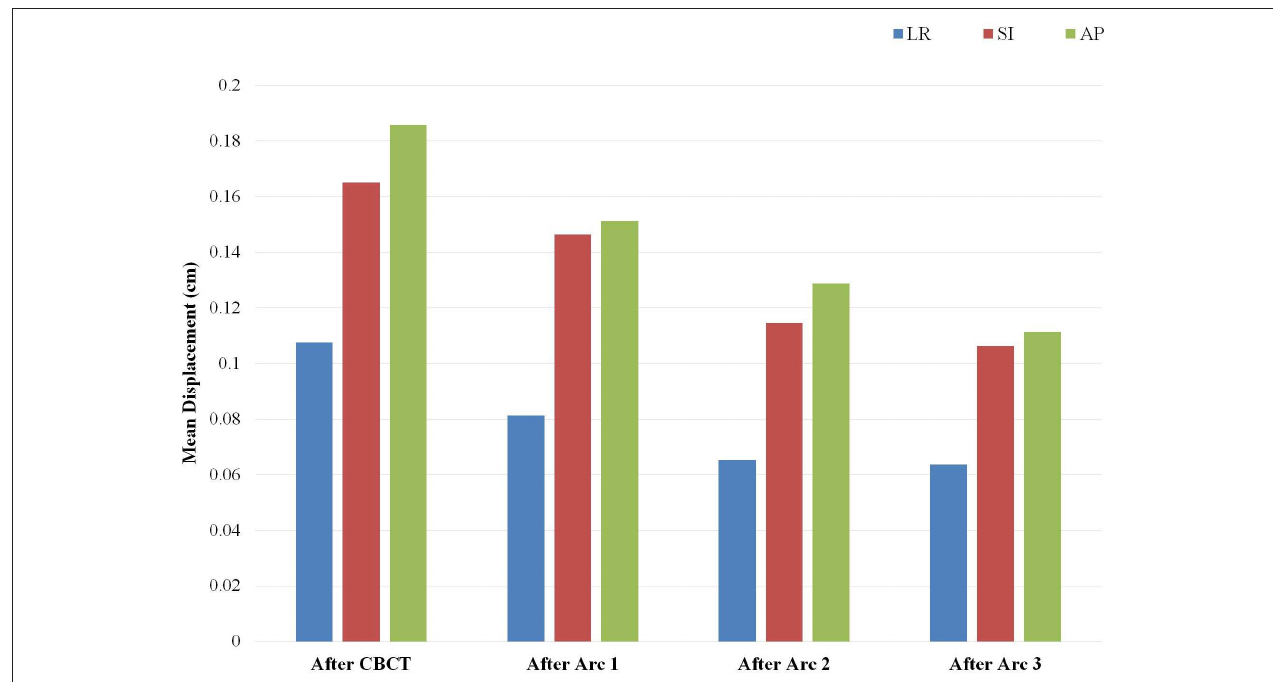
FIGURE 3 | Mean implemented shifts for prostate displacement sequentially over the phases of treatment: from cone beam computed tomography (CBCT) to planar imaging just prior to initiation of arc 1, and between each of the partial arcs incorporating the displacement detected on the image pair obtained subsequent to the corresponding arc. Depicted mean shifts are relative to the immediate predecessor intra-fractional displacement and are based on an institutional threshold of implementing shifts with displacement ≥ 1mm. Arc 4 is not included, as there is no IGRT performed after completion of the fourth arc delivery.